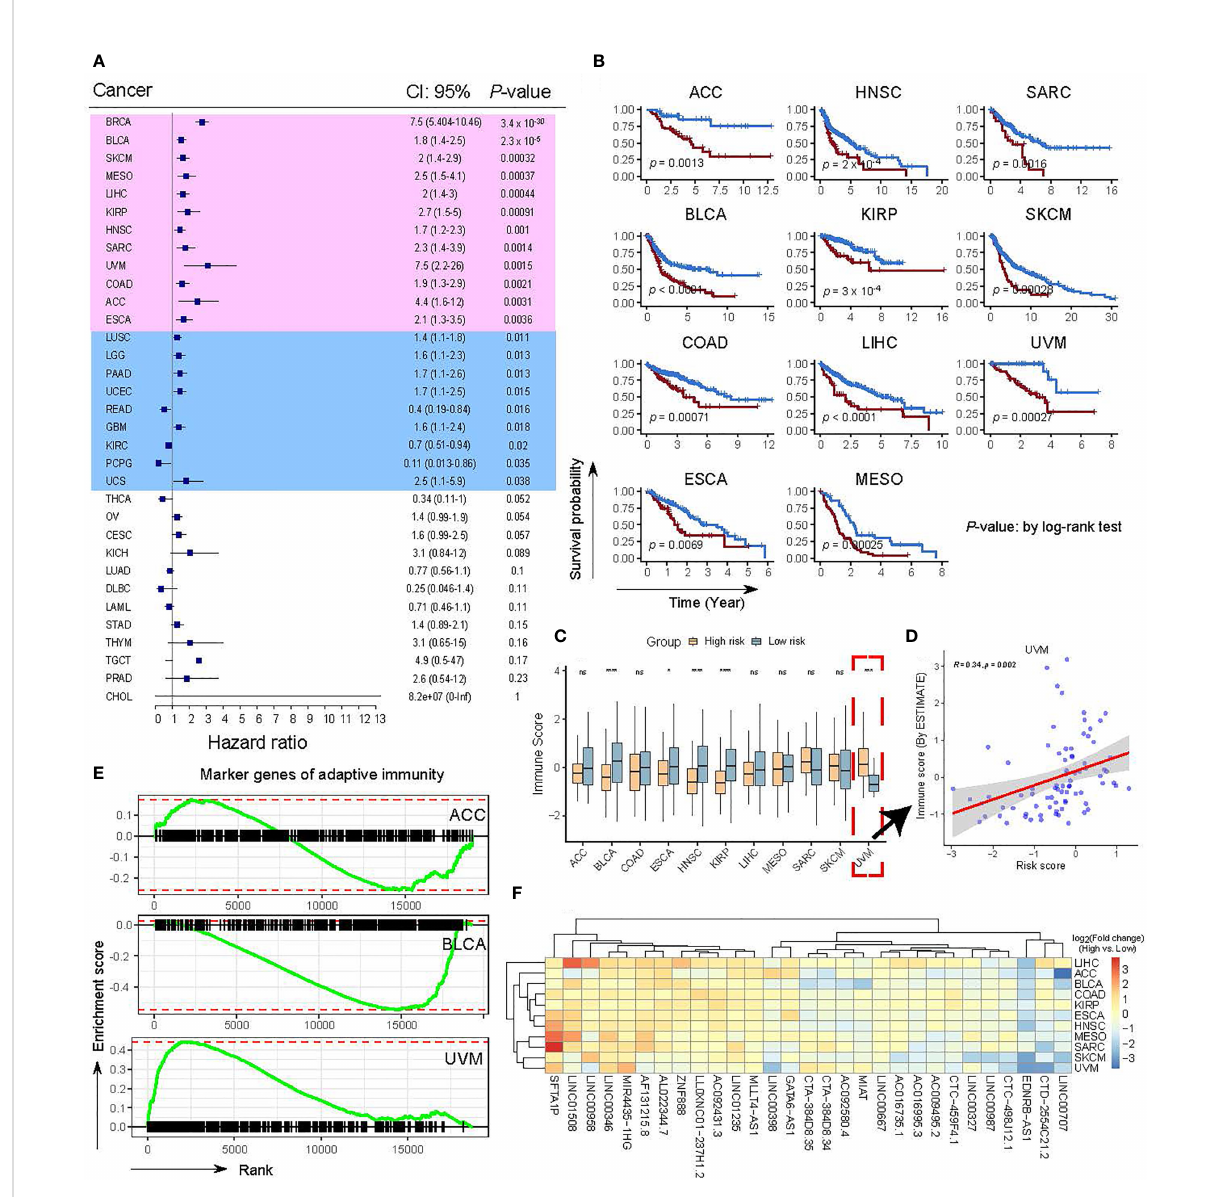
FIGURE 7 Con fi rmation of the OncoSig using TCGA pan-cancer datasets. (A) Validation of the impact of the OncoSig on survival using TCGA pan-cancer datasets. Background colors in pink indicate cancer types with p -values less than 0.01, while light blue indicates cancer types with p -values less than 0.05. P -values were obtained using a log-rank test. (B) KM OS curves between patients with a higher and a lower OncoSig score in 11 cancer types. (C) Comparison of the relative distribution of immune scores derived from ESTIMATE between high- and low-risk groups in 11 cancer types. (D) Scatter plot showing the correlation between the correlated immune score and the OncoSig score. R indicates the Pearson correlation coef fi cient. (E) GSEA for 431 marker genes of adaptive immunity reveals the relationship between low- and high-risk score groups in adrenocortical carcinoma, bladder urothelial carcinoma, and uveal melanoma cancer types. (F) Heat map with hierarchical clustering showing the expression of 29 lncRNAs between low- and high-risk score groups. Red and blue represent high and low expressions, respectively. The Wilcoxon rank-sum test was used for the statistical analysis. ns: not signi fi cant, * p ≤ 0.05, *** p ≤ 0.001, **** p ≤